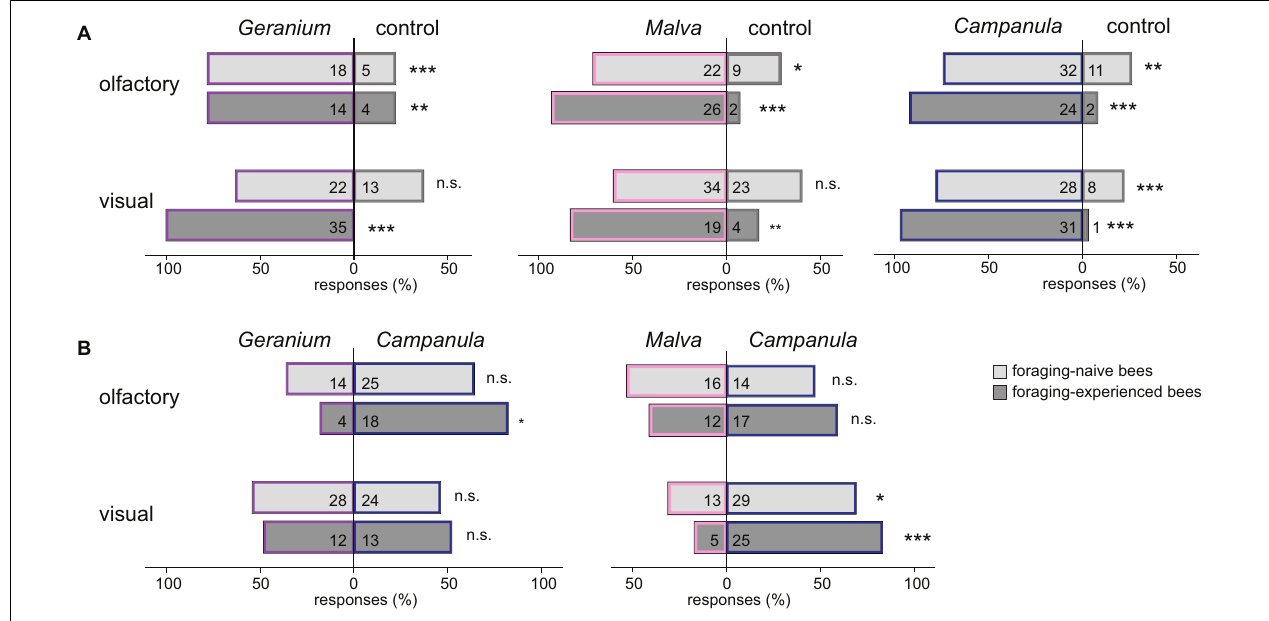
FIGURE 3 | Behavioral responses (in percent) of foraging-naïve (light gray) and foraging-experienced (dark gray) males and females of C. rapunculi to olfactory and visual cues of (A) G. sanguineum , M. moschata , and C. trachelium inflorescences tested against an empty control and (B) G. sanguineum and M. moschata against C. trachelium (exact binomial test: n.s.: P > 0.05, * P < 0.05, ** P < 0.01, *** P < 0.001).